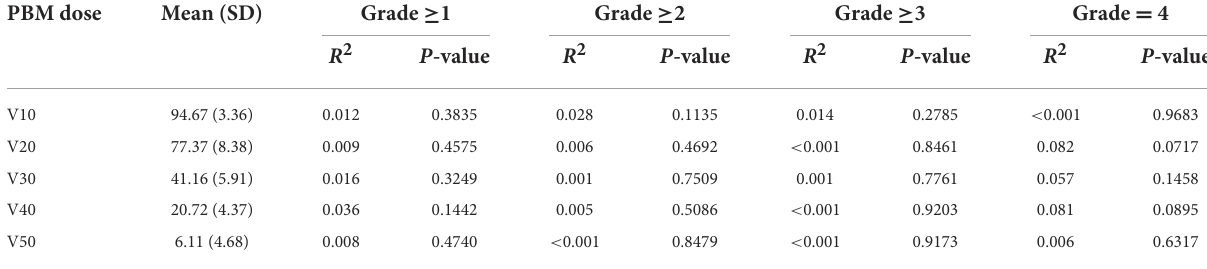
TABLE 3 Univariate analysis of the effect of pelvic bone marrow with different radiation volumes on acute hematological